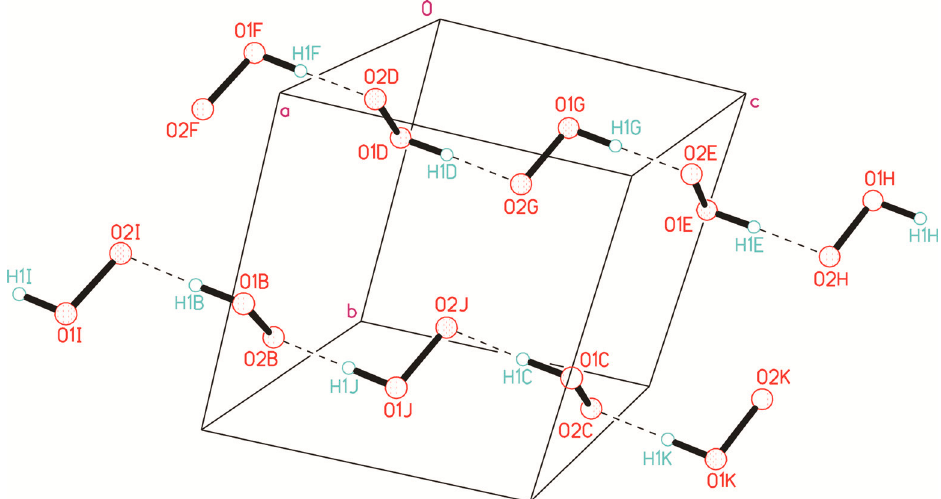
Figure 7. Infinite ionic chains in the NH 4+ OOH − crystal, consisting of HOO − fragments interacting through short (strong) H-bonds, which are given by dashed lines. Reproduced with permission from J. Chem. Phys. 133, 16 (2010). Copyright 2004 AIP Publishing [28].